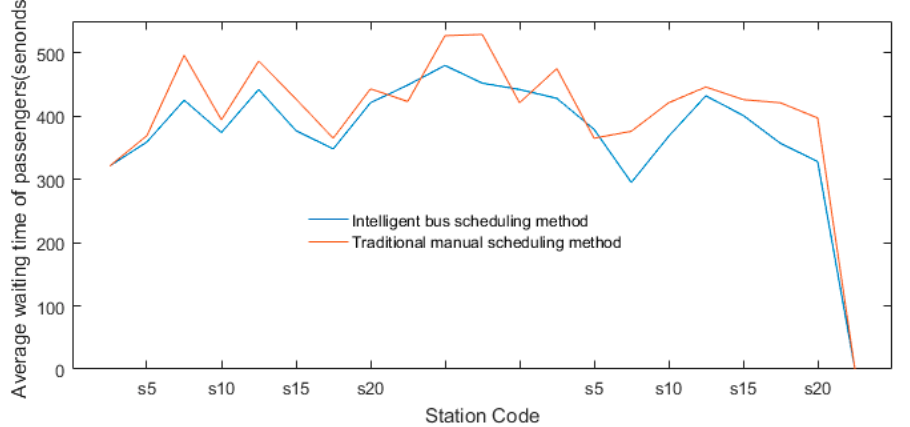
Figure 4. Dispatching results comparison by average waiting time of passengers.